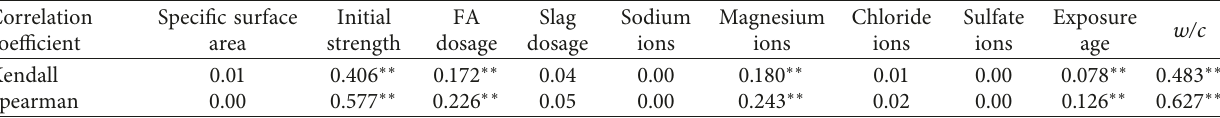
Table 4: Kendall and Spearman correlation coefficients of influencing factors.